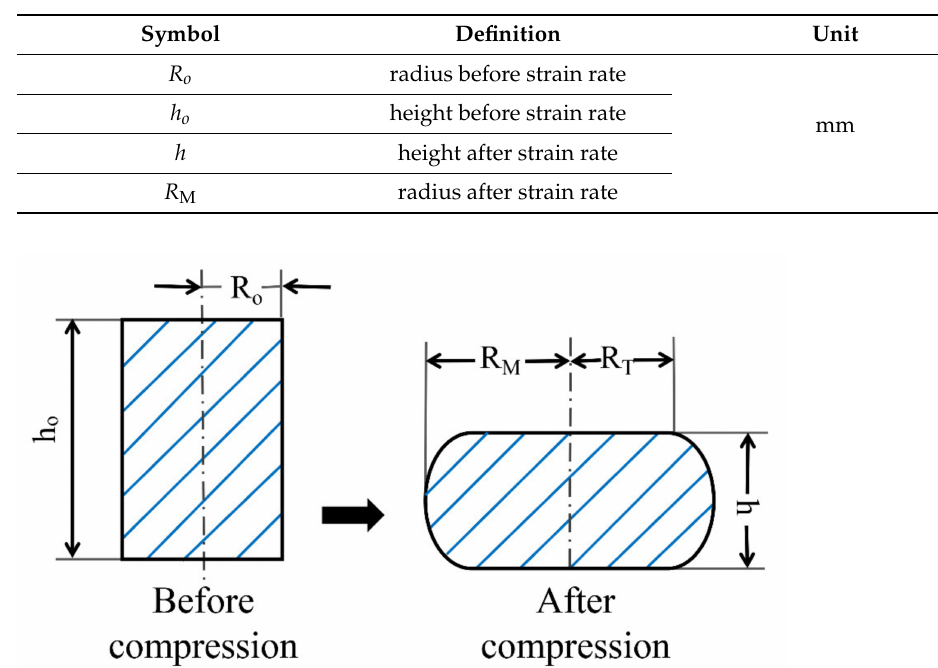
Table 2. Parameter table of friction correction [14,15].